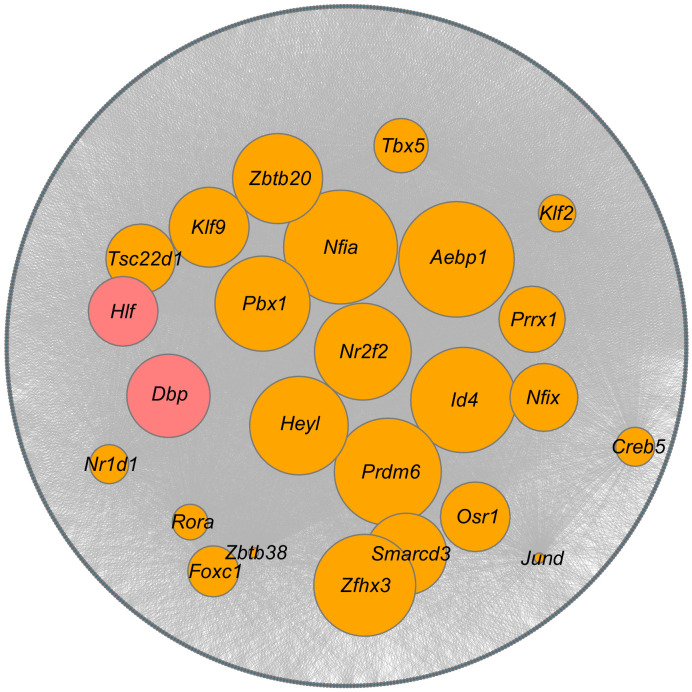
Prediction of key transcription factors (TFs) for the myofibroblast.Top 25 SINCERA predicted TFs from myofibroblast cells in the IH group are selected. The selected TFs are compared to all the predicted TFs from myofibroblast cells in the control group. Orange nodes represent TFs shared between myofibroblast cells in control and IH groups, and red nodes represent specific TFs in myofibroblast cells in the IH group. Gray nodes represent target genes, while edges represent the predicted regulatory interactions between TFs and target genes. The size is in concordance with the average ranking; the higher the ranking, the larger the size.